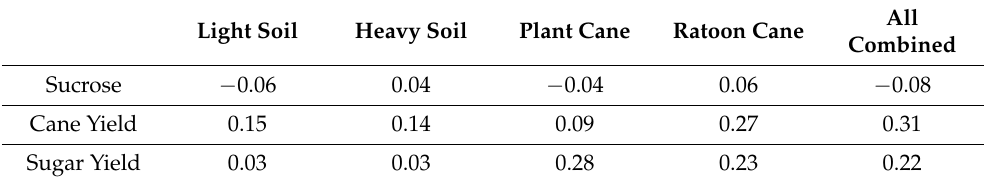
Table 2. The Pearson correlation between the actual (BLUEs) and predicted values (GEBVs) using rrBLUP with sucrose content, cane yield, and sugar yield associated SNPs as the fixed effect. Light